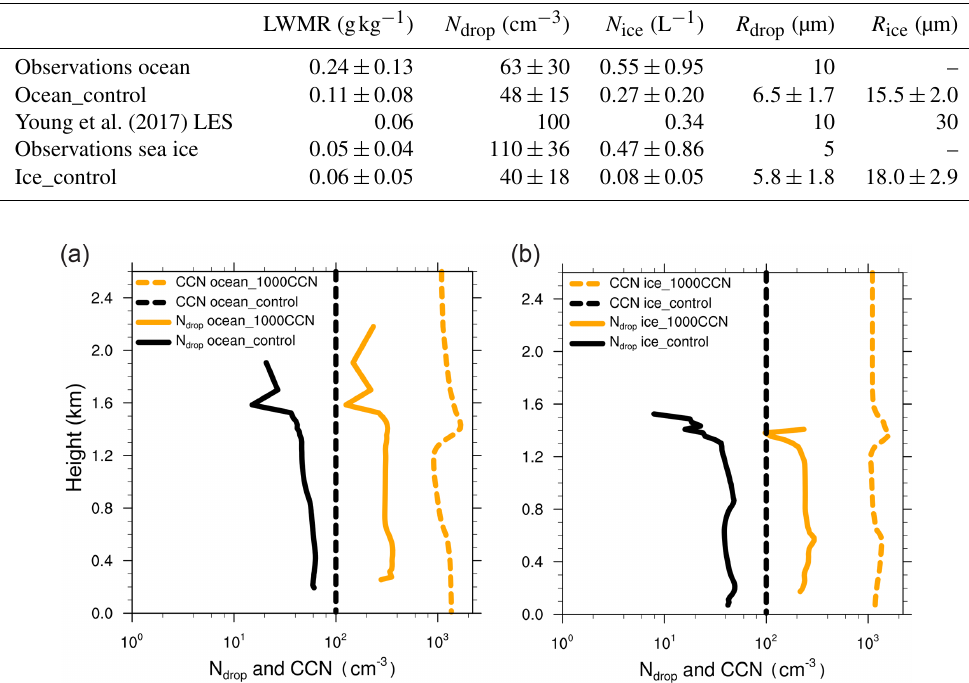
Figure 2. Average (2–20h) N drop (solid lines) and the sum of all CCN tracers, i.e., background and perturbation mode, (dashed lines) in the (a) ocean_control simulation as well as most perturbed 1000CCN simulation and (b) ice_control simulation as well as most perturbed 1000CCN simulation.